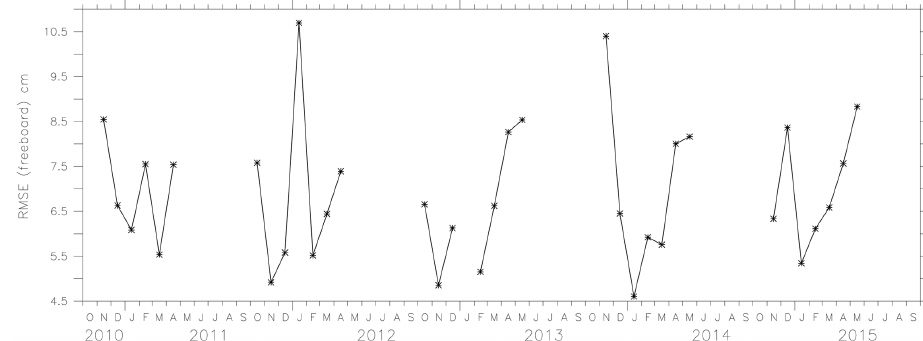
Figure 17. The RMSE of freeboard measure for the regions where the lead fraction is above 0%.